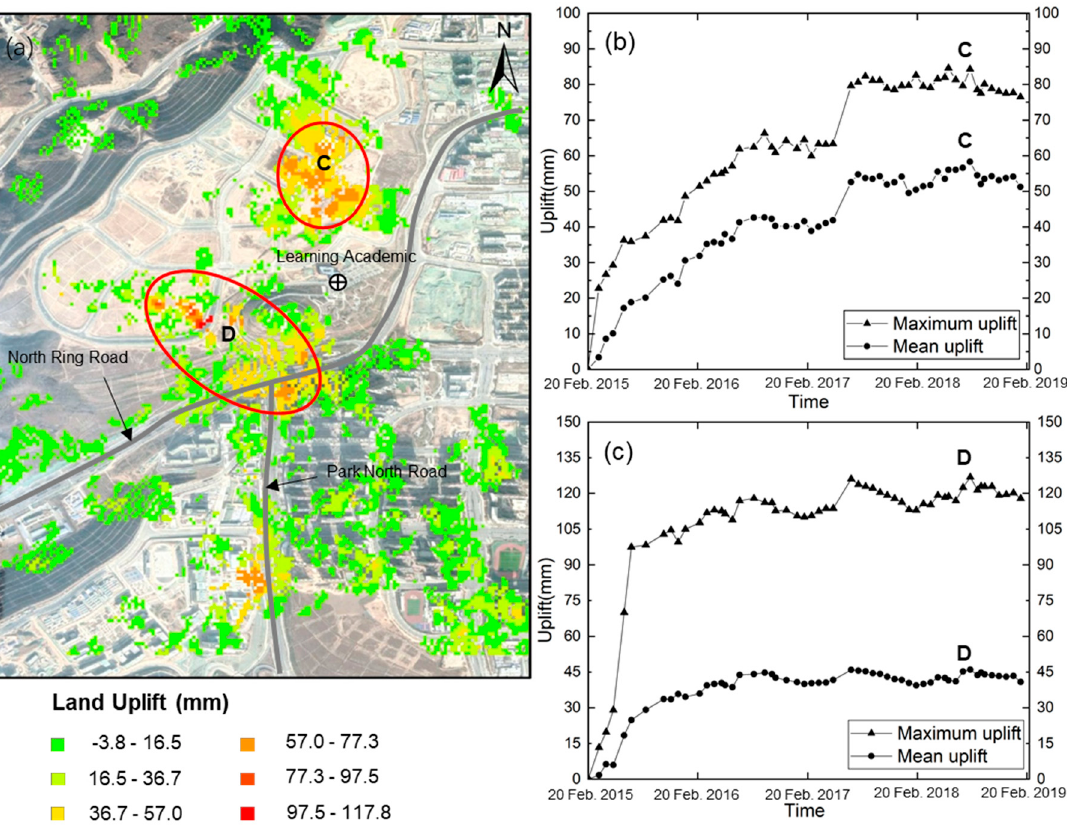
Figure 7. ( a ) The uplifting area in YND superimposed on the Google Earth image; ( b , c ) represent the evolution of land uplift of region C and D, respectively.